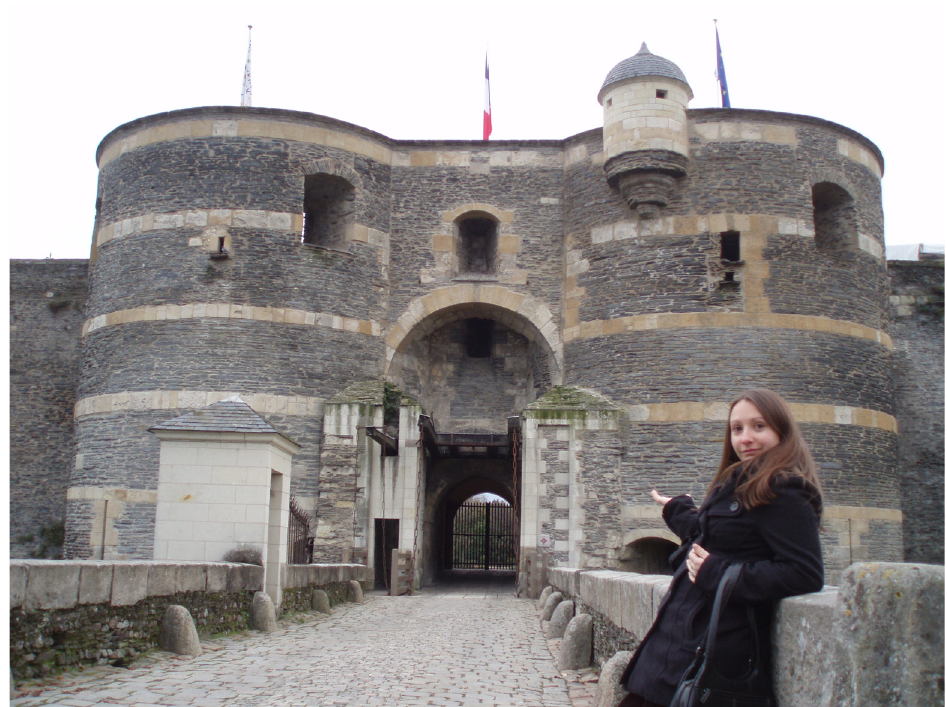
Fig. 4: J. Patenaude